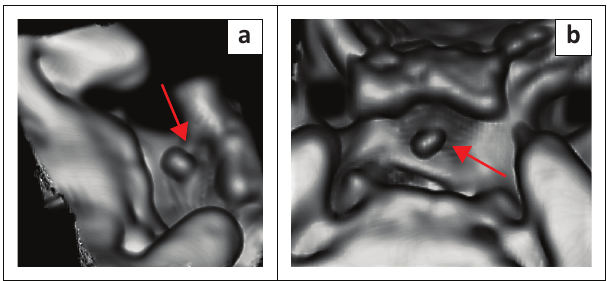
FIGURE 2: Volume rendered CT of the sella turcica, (a) oblique view and (b) superior view, demonstrating the sellar spine (arrow) protruding into the pituitary